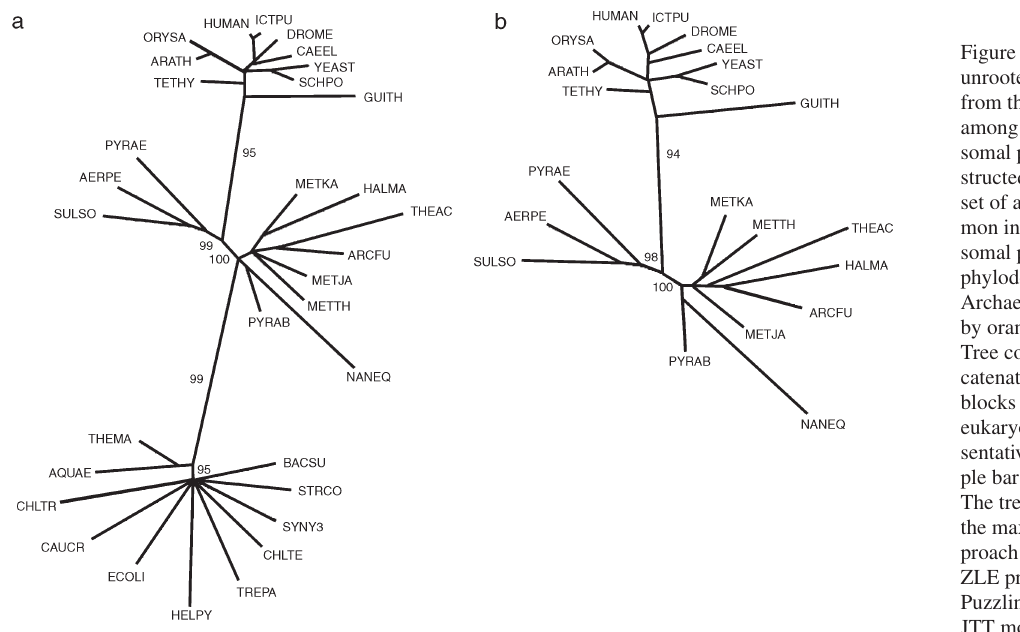
codes: Eukarya (top set): ARATH = Arabidopsis thaliana , CAEEL = Caenorhabditis elegans , DROME = Drosophila melanogaster , GUITH = Guillardia theta , HUMAN = Homo sapiens , ICTPU = Ictalurus punctatus , ORYSA = Oryza sativa , SCHPO = Schizosaccharomyces pombe , TETHY = Tetrahymena thermophila and YEAST = Saccharomyces cerevisiae ; Archaea (middle set): AERPE = Aeropyrum pernix , ARCFU = Archaeoglobus fulgidus , HALMA = Haloarcula marismortui , METJA = Methanococcus jannischii , METKA = Methanopyrus kandleri , METTH = Methanobacterium thermoautotrophicum , NANEQ = Nanoarchaeum equitans , PYRAB = Pyrococcus abyssi , PYRAE = Pyrobaculum aero- philum , SULSO = Sulfolobolus solfataricus and THEAC = Thermoplasma acidophilum ; Bacteria (bottom set): AQUAE = Aquifex aeolicus , BACSU = Bacillus subtilis , CAUCR = Caulobacter crescentus , CHLTR = Chlamydia trachomatis , CHLTE = Chlorobium tepidum , ECOLI = Escherichia coli , HELPY = Helicobacter pylori , STRCO = Streptomyces coelicolor , SYNY3 = Synechocystis sp . (strain PCC 6803), THEMA = Thermotoga maritima and TREPA = Treponema pallidum